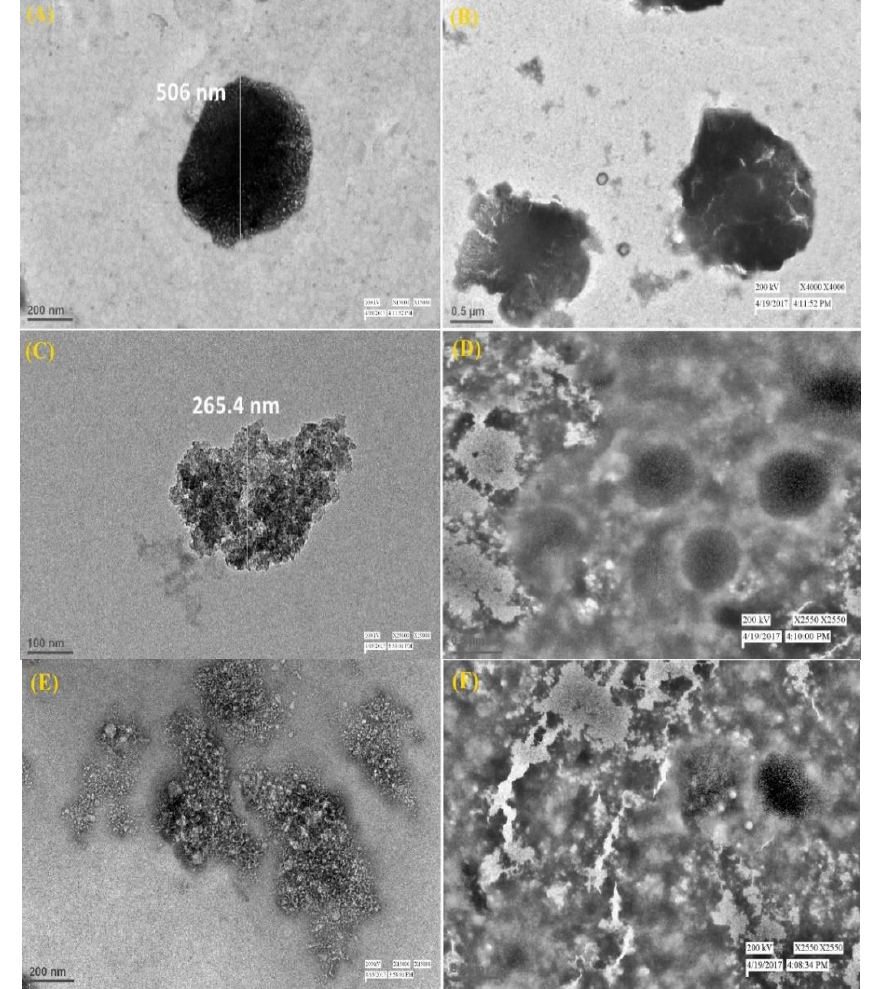
Figure 3. Typical transmission electron microscopy (TEM) analysis of Ca5(PO4)2SiO4 (CPS)-1 ( A , B ), CPS-2 ( C , D ) and CPS-3 ( E , F ).